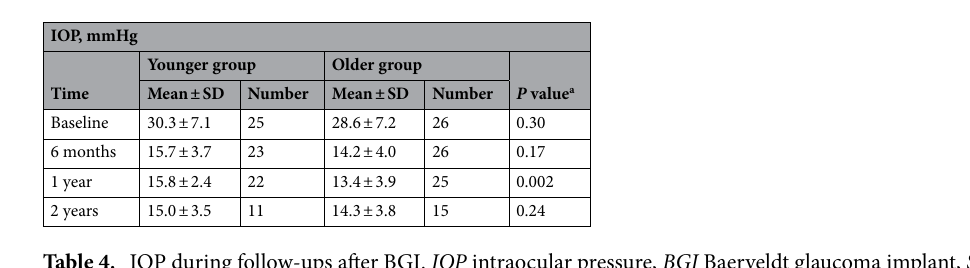
Table 4. IOP during follow-ups after BGI. IOP intraocular pressure, BGI Baerveldt glaucoma implant, SD standard deviation. a Mann–Whitney U